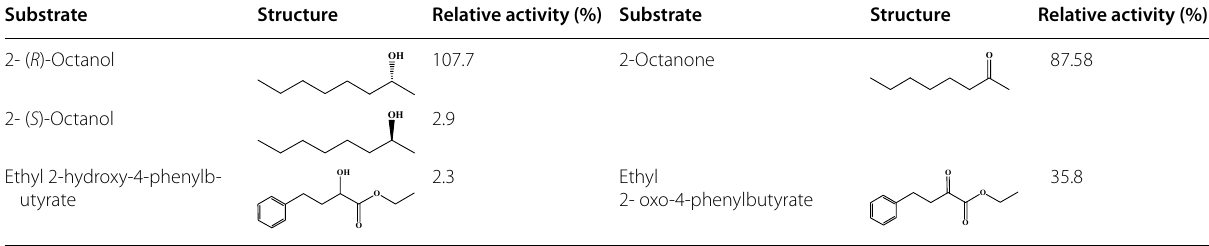
Table 4 Asymmetric reduction of prochiral carbonyl compounds catalyzed by the recombinant AcCR